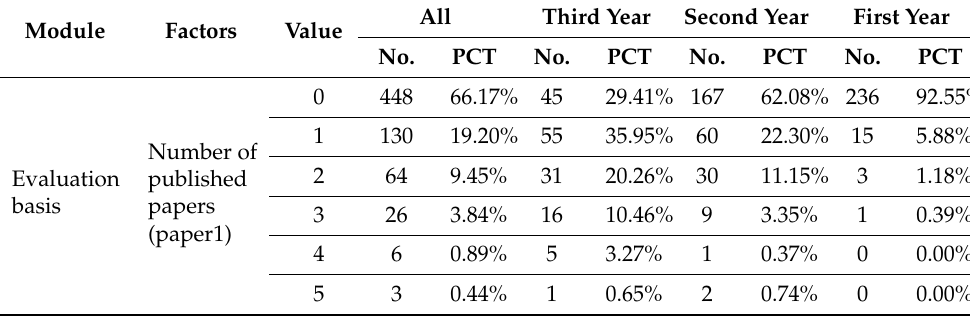
Table 2. The descriptive results of questionnaires about evaluation